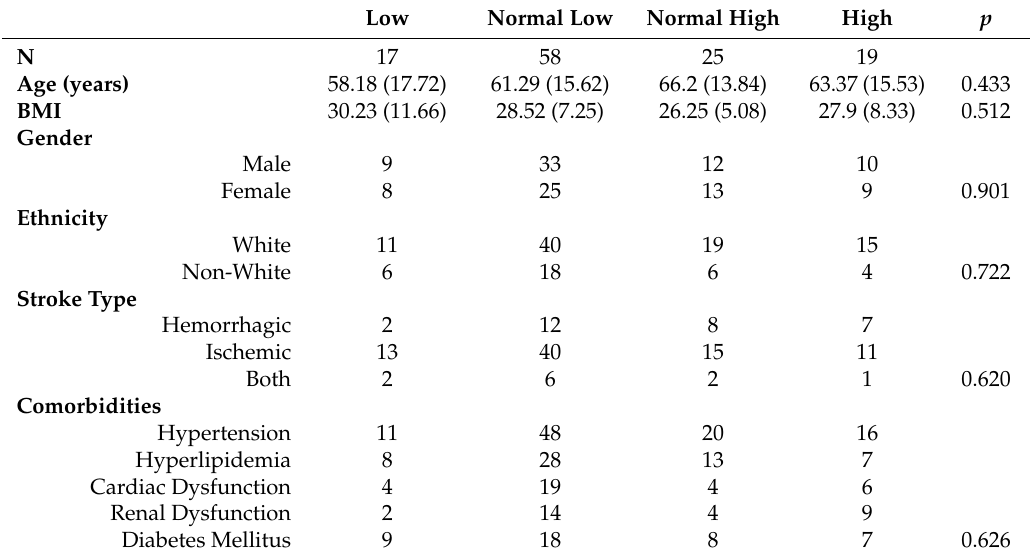
Table 1. Patient characteristics.